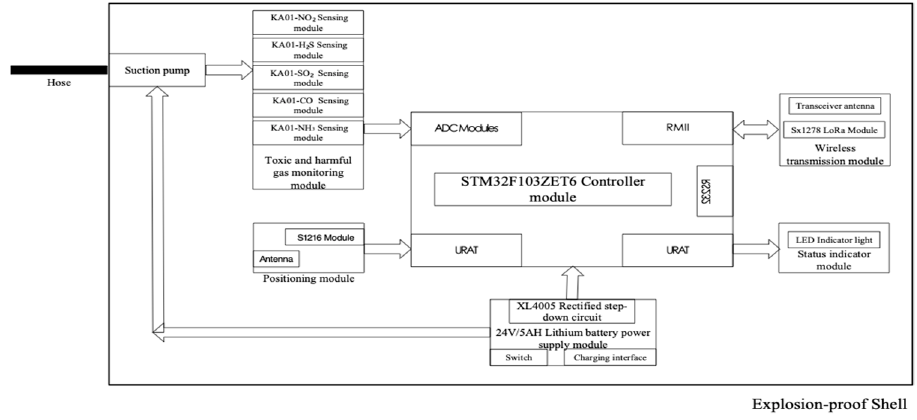
Figure 2. The Terminal Schematic.